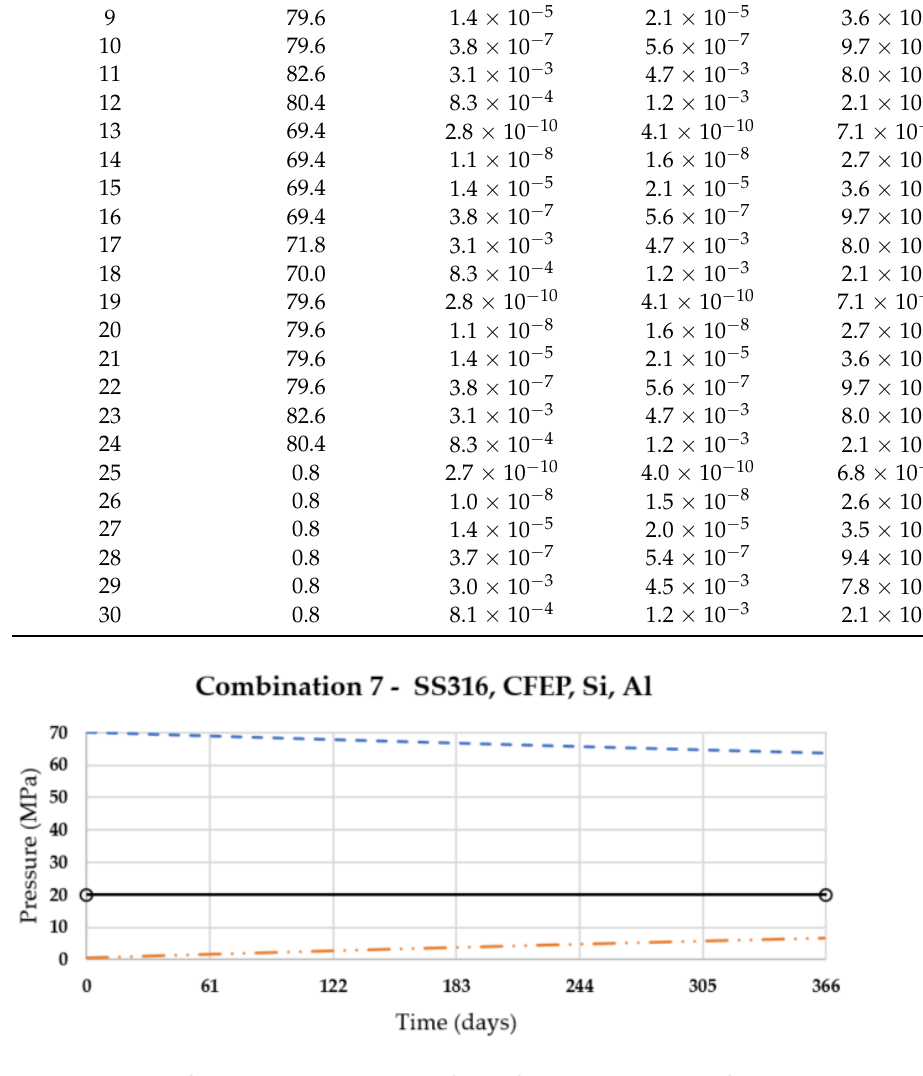
Figure 4. Pressure inside of the spheres and the envelope tank, combination 7 from Table 3.